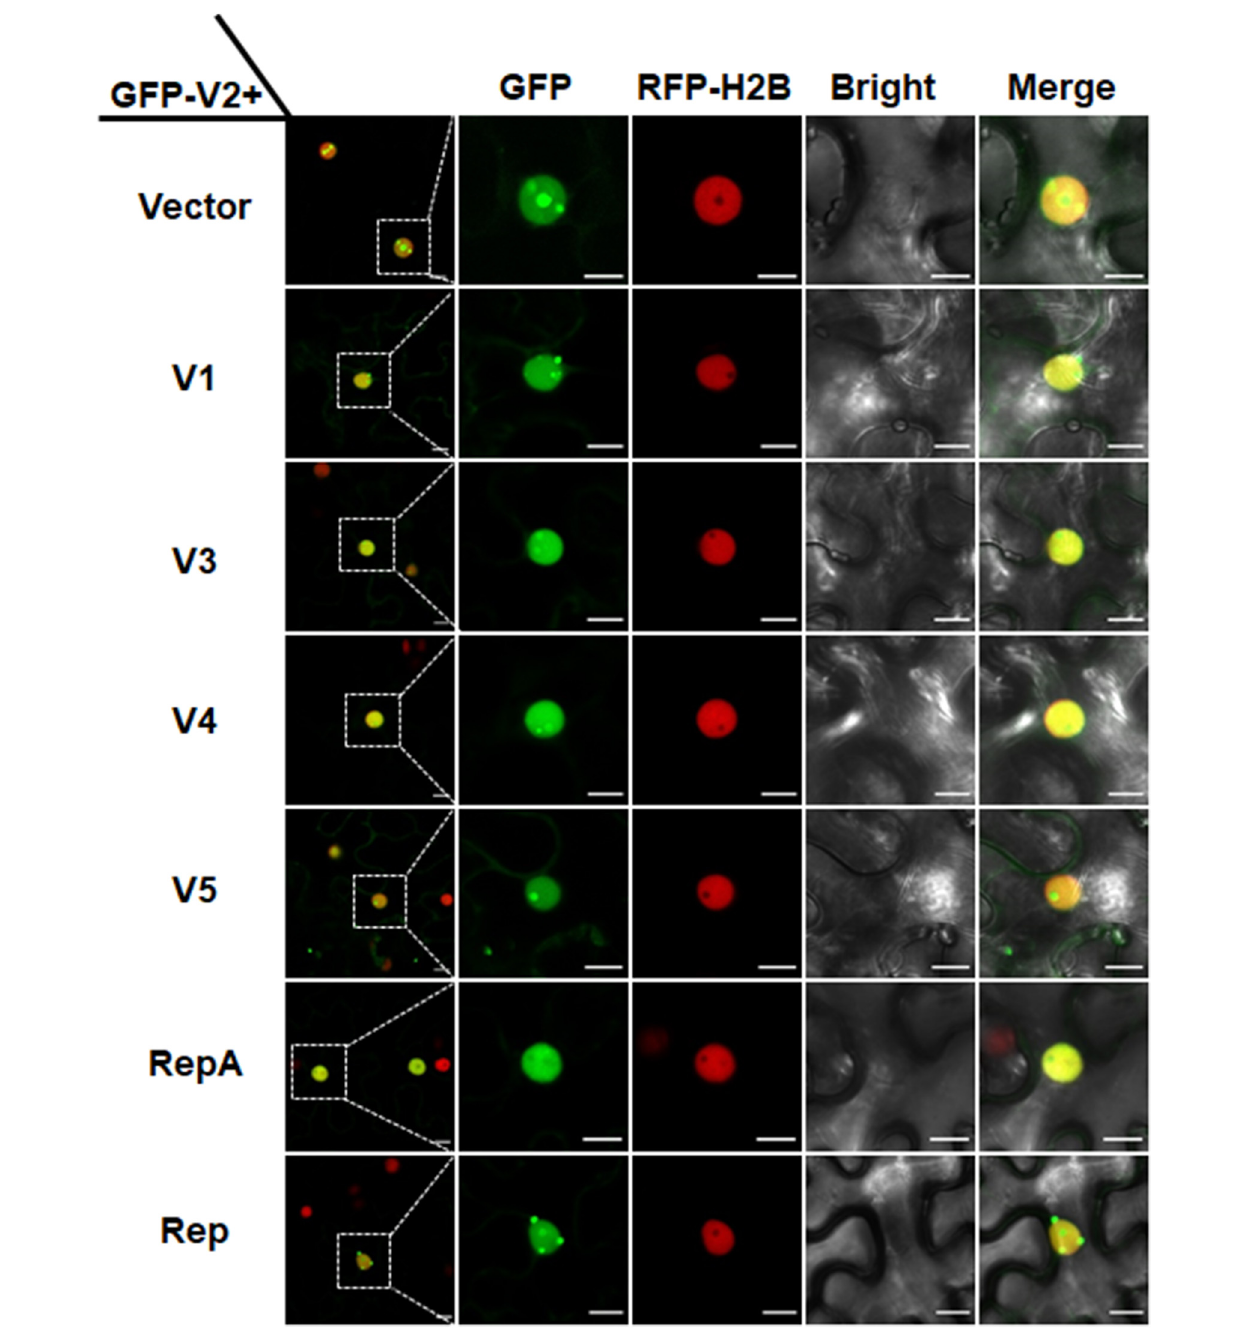
FIGURE 3 | RepA-dependent nucleolar exclusion of V2. RFP-H2B plant leaves were infiltrated with Agrobacterium tumefaciens cultures carrying constructs to express GFP-V2 and the other six individual ORFs (V1, V3, V4, V5, RepA, and Rep) of MMDaV. Fluorescence was visualized under a Zeiss LSM 880 confocal laser scanning microscope at 36 hpi. The corresponding region in the white box in column 1 is magnified and shown from Column 2 to Column 5. RFP-H2B was used as a nuclear marker. This experiment was done three times and more than 20 cells were observed per sample and replicate. Scale bars correspond to 10 µ m.